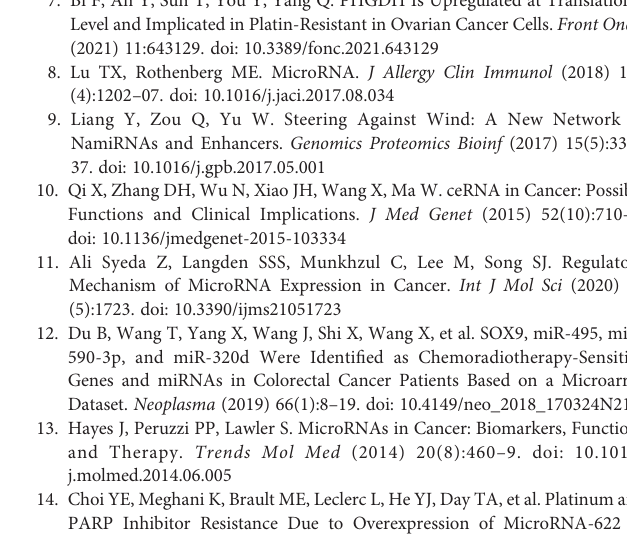
Supplementary Figure 1 | Boxplot and PCA of differentially expressed lncRNAs, mRNAs and microRNAs. (A-C) Boxplot of differentially expressed lncRNAs, mRNAs and microRNAs between platinum-resistant and platinum-sensitive groups, respectively. (D-F) PCA of differentially expressed lncRNAs, mRNAs and microRNAs between platinum-resistant and platinum-sensitive groups, respectively. PCA, Principal Component Analysis; PR, platinum-resistant; PS, platinum-sensitive. Supplementary Figure 2 | Chord diagram of mRNAs enriched in KEGG pathways. Different colors on the right of the chord diagram represent different KEGG pathways, corresponding to legend, the left of the chord diagram represents mRNAs enriched in different KEGG pathways, and the line in the middle represents mRNAs are enriched in KEGG pathways. Supplementary Figure 3 | Effect of miR-320b and miR-320d as biomarkers to predict overall survival in ovarian cancer patients receiving platinum-based chemotherapy by survival curves. (A, B) Survival curves of high expression group and low expression group judged by expression levels of miR-320b and miR-320d